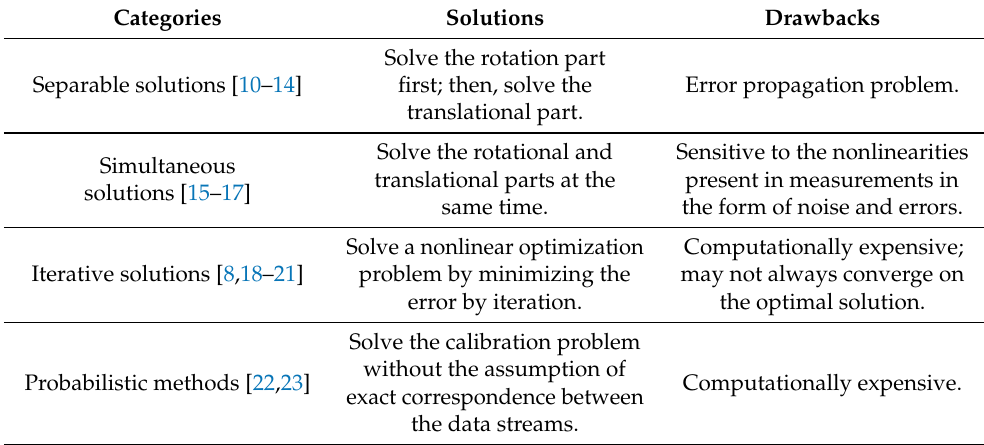
Table 1. Comparison of existing solutions to the hand–eye calibration problem.